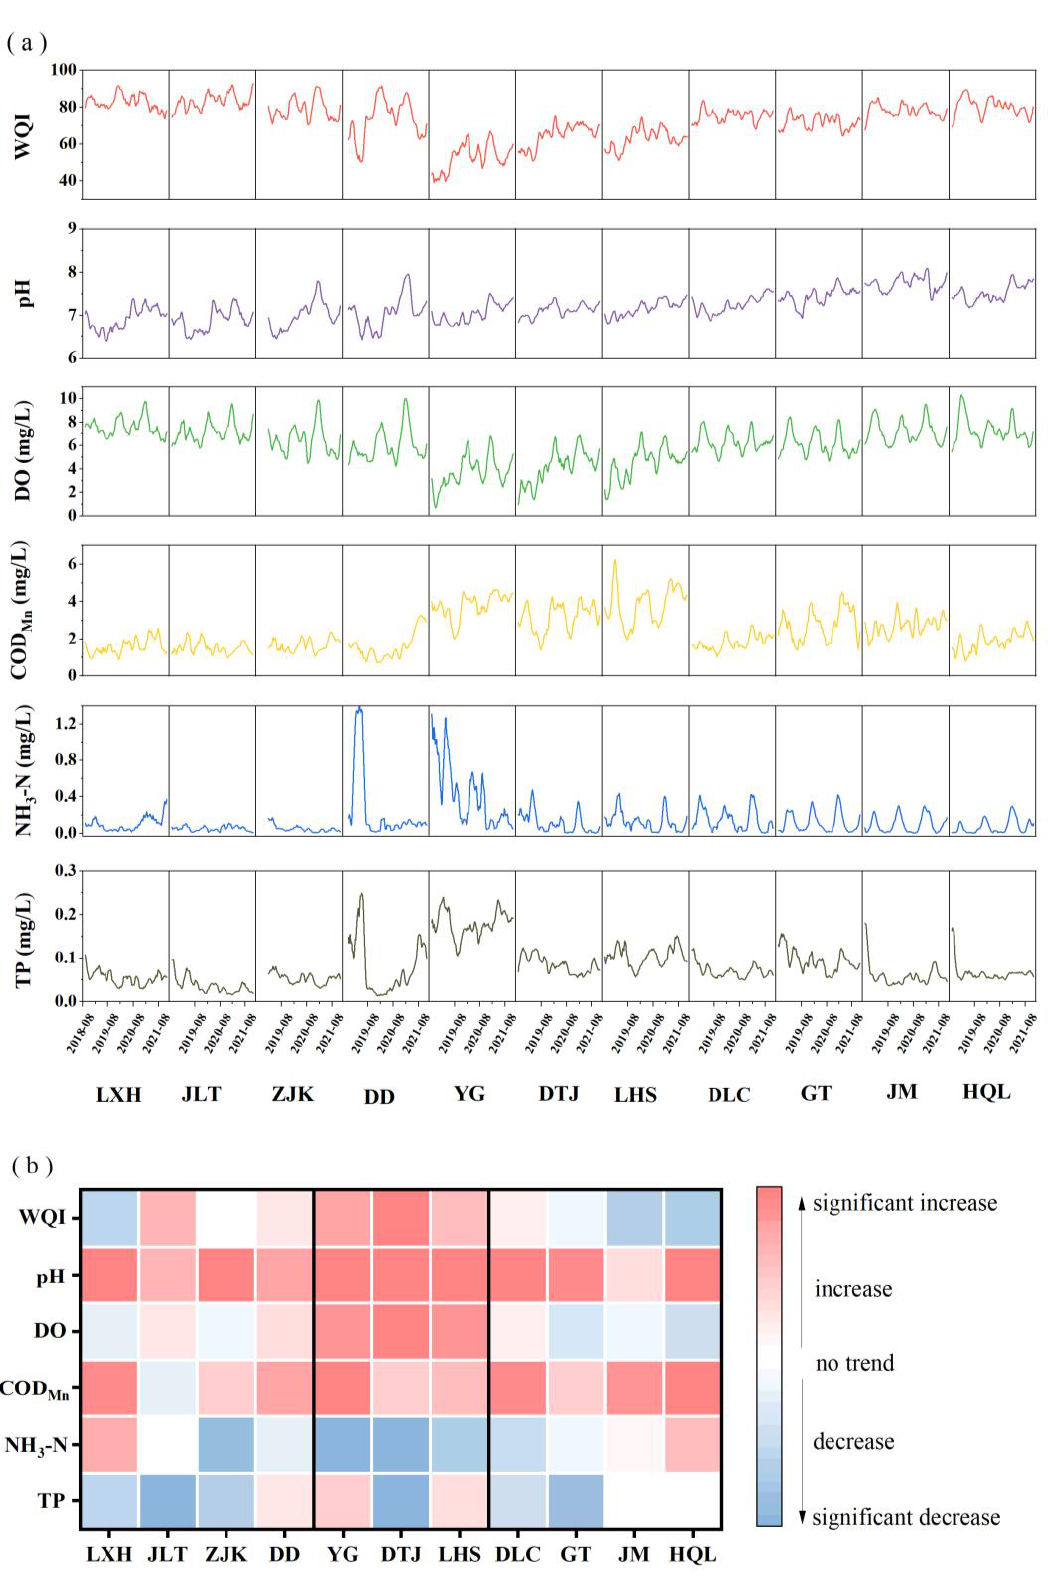
Figure 3. ( a ): Long-term trend for river water quality in Guangzhou reach of the Pearl River from 2018 to 2021; ( b ): Mann–Kendall test results for water quality parameters at each sampling site. The monitoring stations in the southern basin were surrounded by farmlands and fishponds. Therefore, TP can be unavoidably released into rivers from agricultural sources through surface runoff, subsurface flow, farm drainage and seepage [33]. The substantial decrease in the TP levels in October 2018 might be attributable to a series of remedial measures implemented by the Chinese central and local governments aimed at controlling both agricultural and aquaculture pollution from non-point sources at large scale.